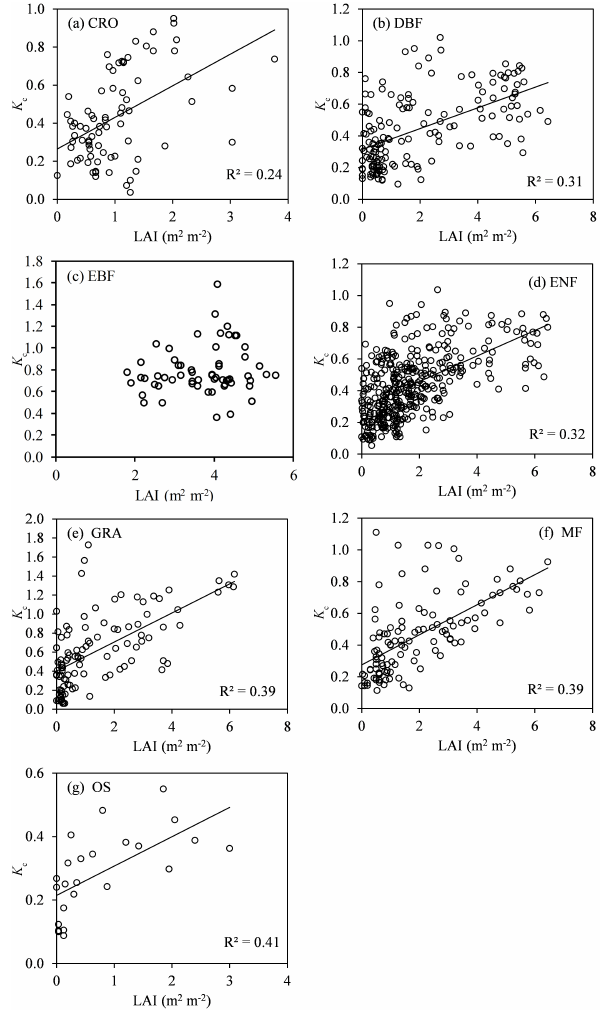
Figure 6. Relationships between the average monthly K c and monthly precipitation ( P , mm) for different vegetation surfaces. Panels (a–g) represent cropland (CRO), deciduous broad leaf for- est (DBF), evergreen broad leaf forest (EBF), evergreen needle leaf forest (ENF), grassland (GRA), mixed forest (MF), and open shrub- land (OS), respectively. All the determination coefficients ( R 2 ) listed in the figure were significant ( p <0.001).